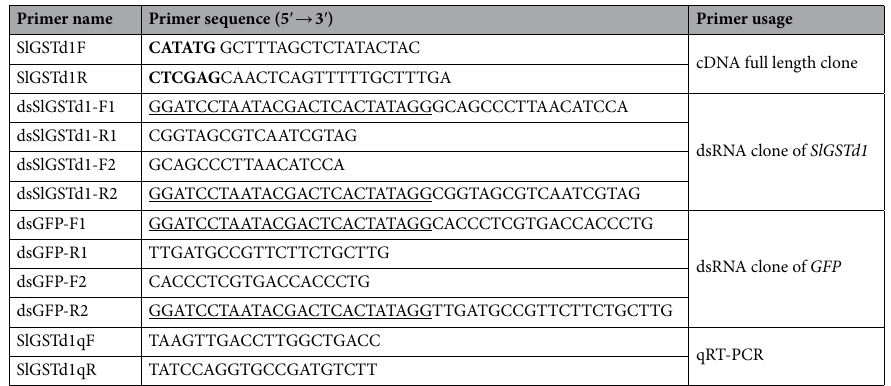
Table 2. Primer pairs used in this study. Nucleotides bold were restriction enzyme sites. Nucleotides underlined were T7 RNA polymerase promoter